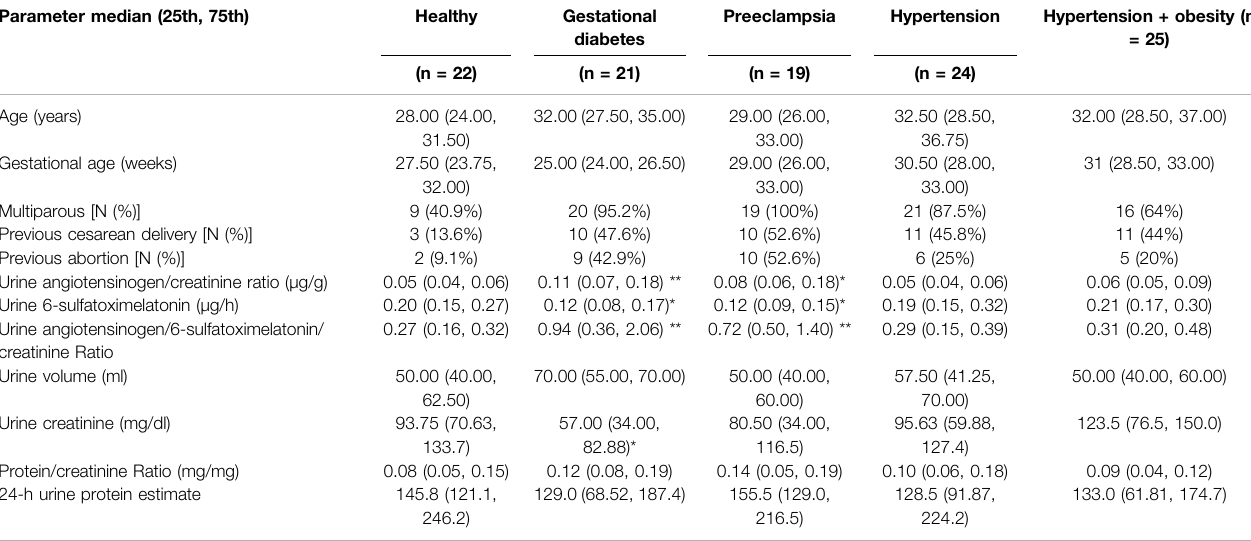
TABLE 1 | Patient demographics and laboratory urine analyses in the studied cohort.